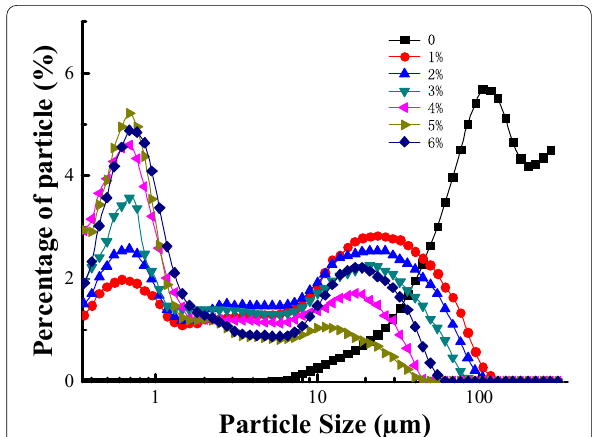
Fig. 4 Particle size distribution of SPH at 0–6% DH,